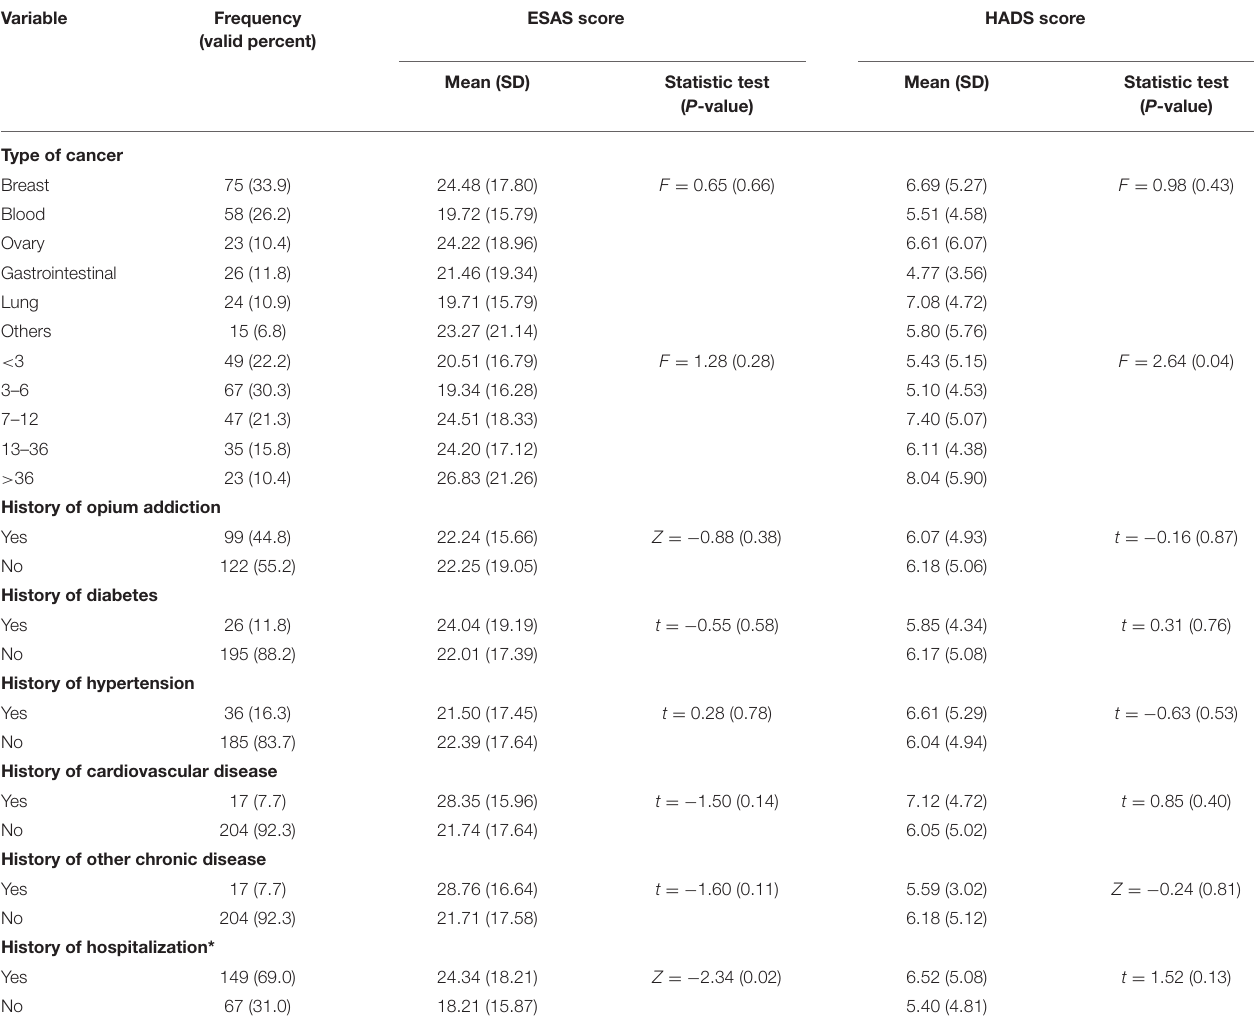
TABLE 2 | Clinical characteristics of the participants and psychosomatic symptoms differences among the participants.